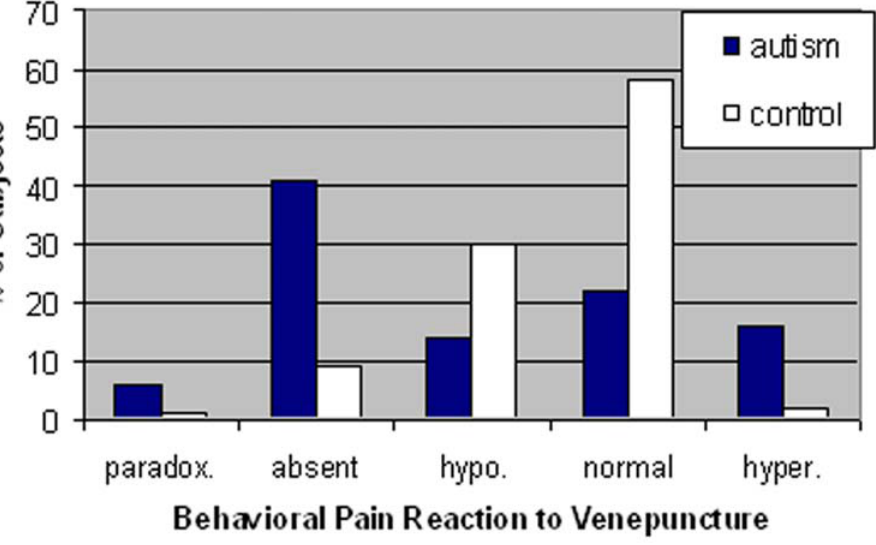
Figure 2. Distribution of types of pain reactivity to venepuncture with nurse and child psychiatrist as observers. Types/class of pain reactivity are described in detail in Table 3 and the numerical data are presented in Table 4.